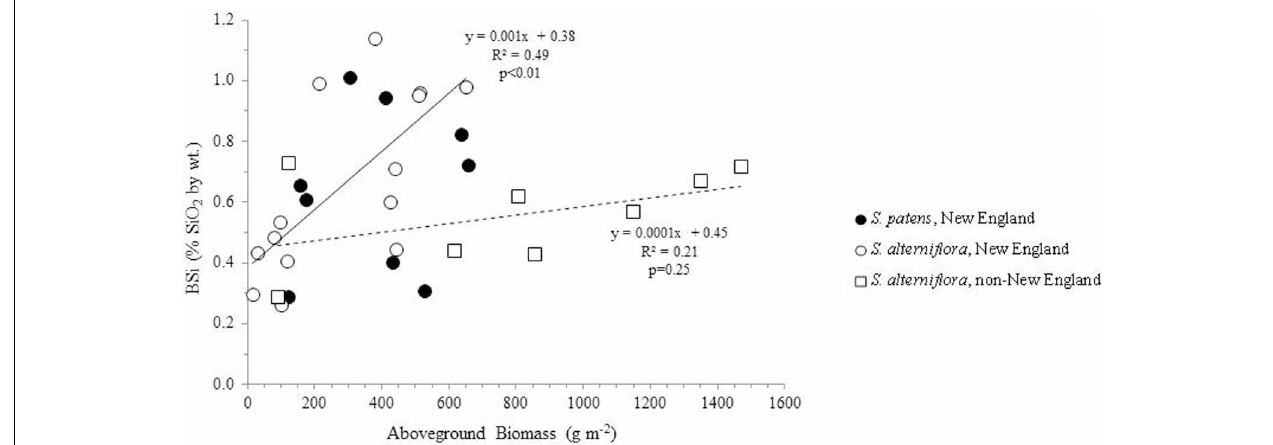
FIGURE 2 | BSi concentration in aboveground Spartina ( S. alterniflora and S. patens ) as a function of productivity. Using the entire dataset, no relationships were found in the data ( R 2 = 0 . 05, n = 31). Similarly, no relationships between the variables were found in S. patens (filled circles) ( R 2 = 0 . 02, n = 9) or non-New England S. alterniflora ( R 2 = 0 . 21, n = 8) (dashed trend line). However, New England S. alterniflora BSi concentrations showed a significant ( p < 0 . 01, n = 14) positive relationship with productivity